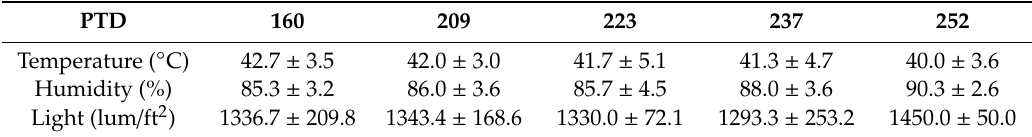
Table A1. Average values of temperature, humidity and light for the measurements made in the greenhouse at the di ff erent PTDs.